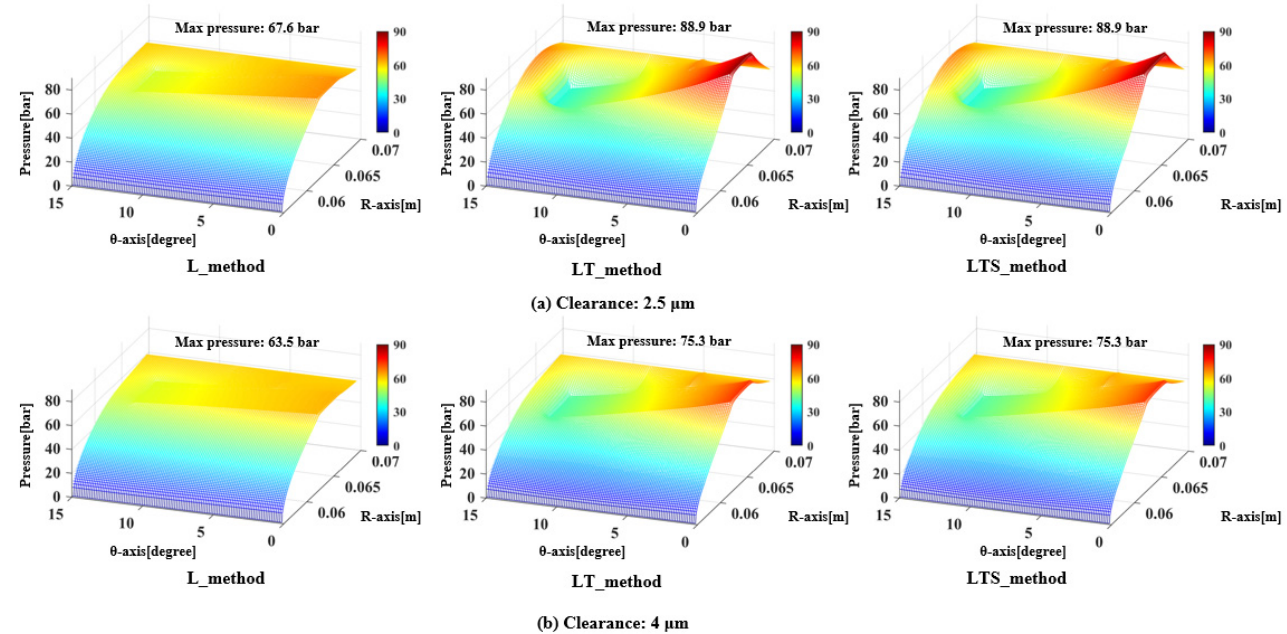
Figure 8. Pressure due to the laminar, turbulent, and slip conditions of the fluid film at an outer pressure of 60 bar.